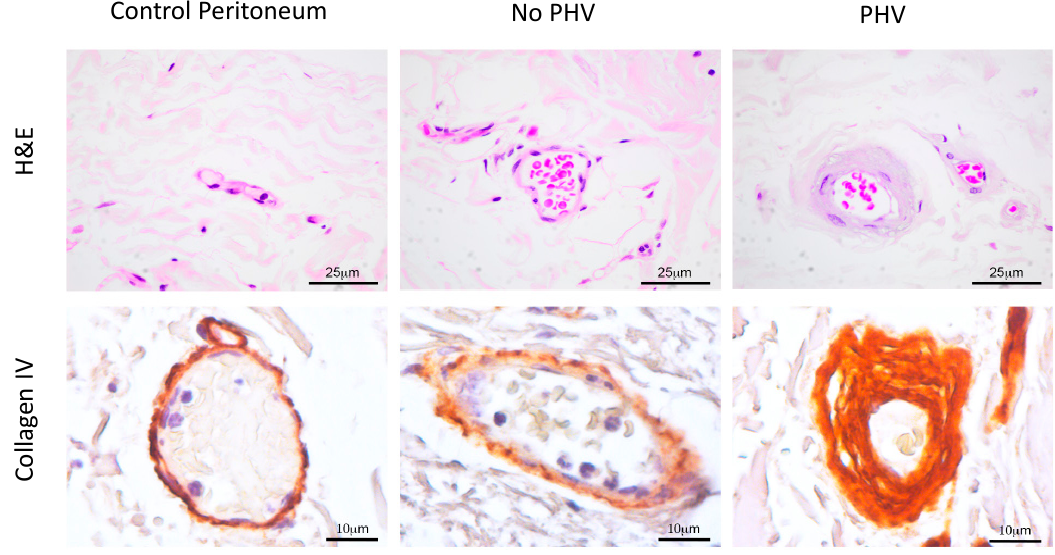
Figure 3. Collagen IV immunohistochemical analysis in peritoneal biopsies. A representative hematoxylin–eosin (H&E) image shows subendothelial thicknesses of the basement membrane in a PHV lesion. Immunostaining images show a PHV strongly stained for collagen IV in the basement membrane, as compared to a control sample or a PD-treated patient without PHV.